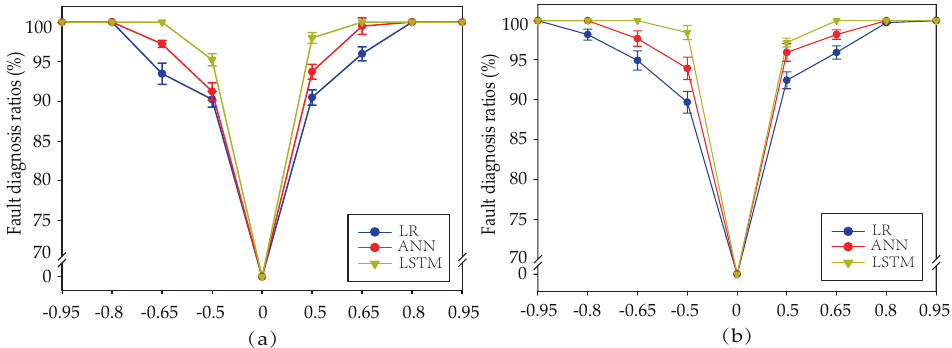
Figure 8. ( a ) Average fault diagnosis ratio of temperature sensor T suc with different biases. ( b ) Average fault diagnosis ratio of temperature sensor P suc with different biases.